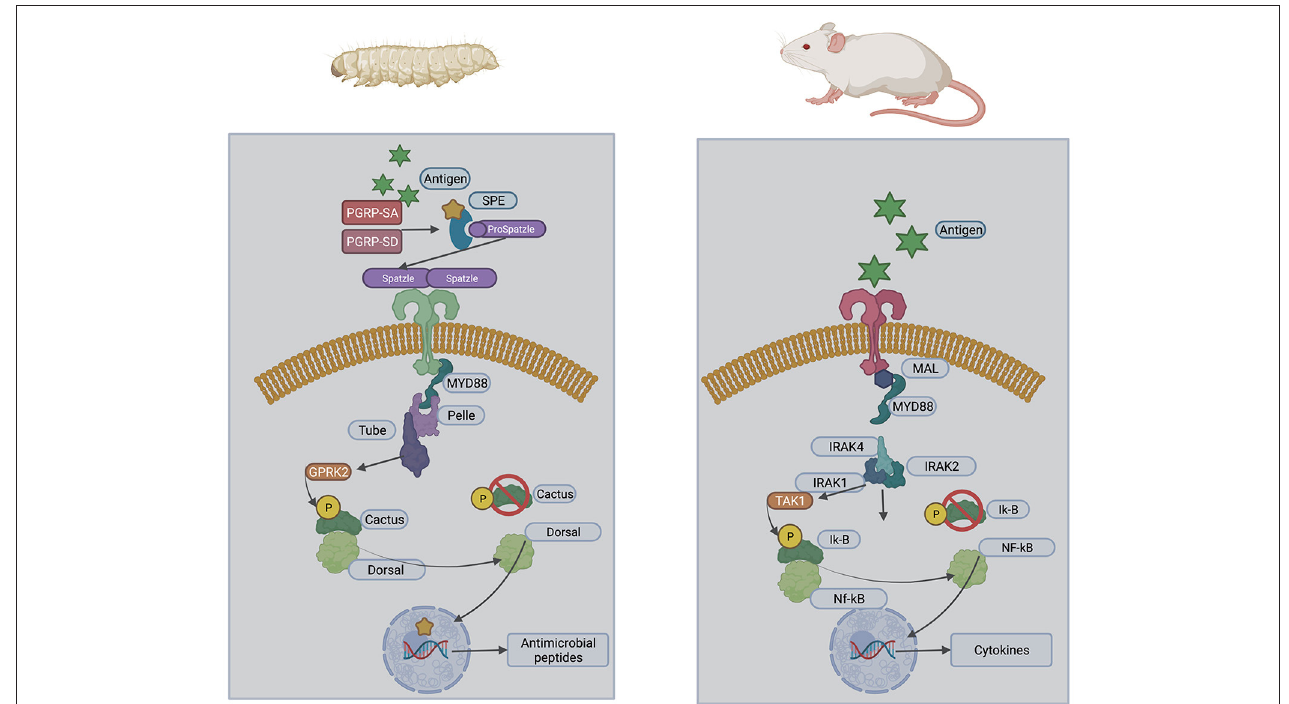
FIGURE 1 | Structural similarities of the insect and mammalian Toll